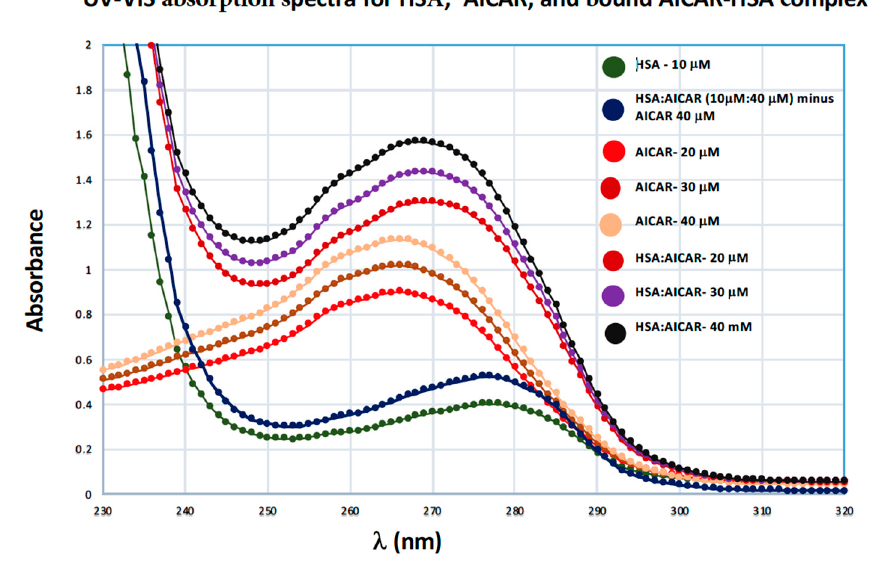
Figure 6. UV-VIS absorption spectra of free HSA (10 μ M), AICAR–HSA (40:10 μ M) subtracted from AICAR 40 μ M, free AICAR (20, 30, 40 μ M), AICAR–HSA complexes (20:10, 30:10, 40:10 μ M), pH 7.4, 10x- PBS buffer at 298 K.